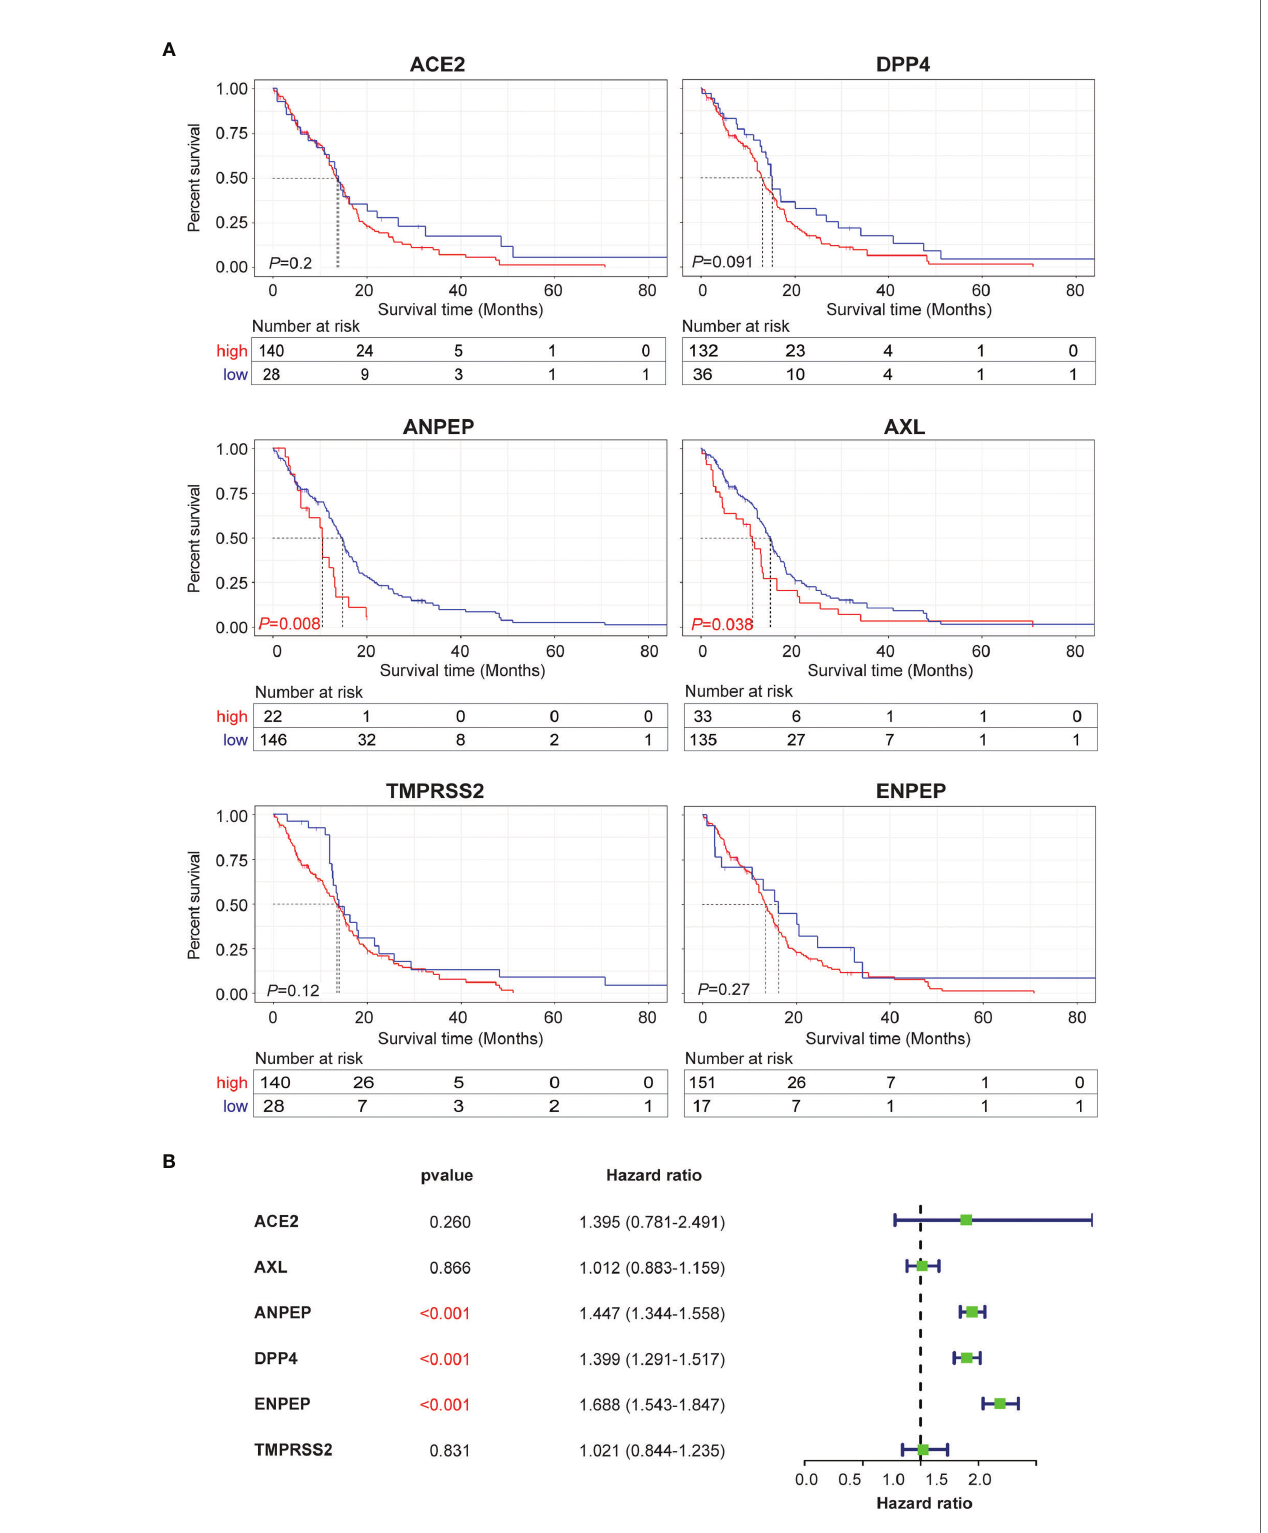
FIGURE 3 | Prognosis and survival analysis of coronavirus receptors in GBM. (A) Kaplan – Meier survival curves in the TCGA database. Red indicates high expression, and blue indicates low expression (n = 168). (B) Forest plot for the univariate Cox proportional hazard regression model in the CGGA database (n =